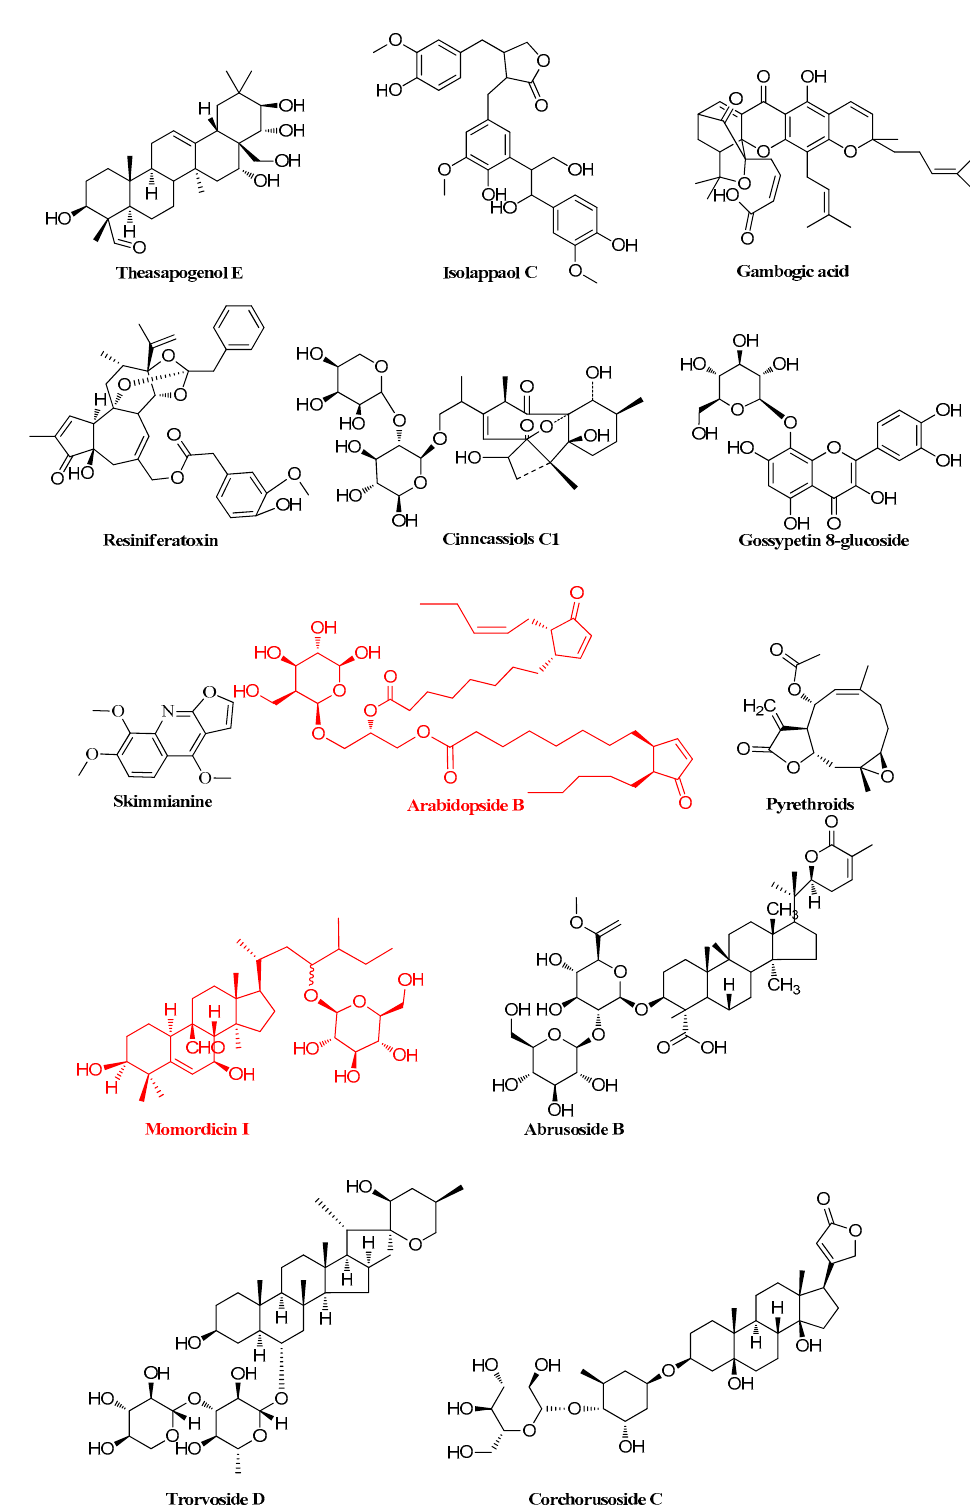
Figure 11. 14 Metabolites related to insect resistances based on up-regulated compounds